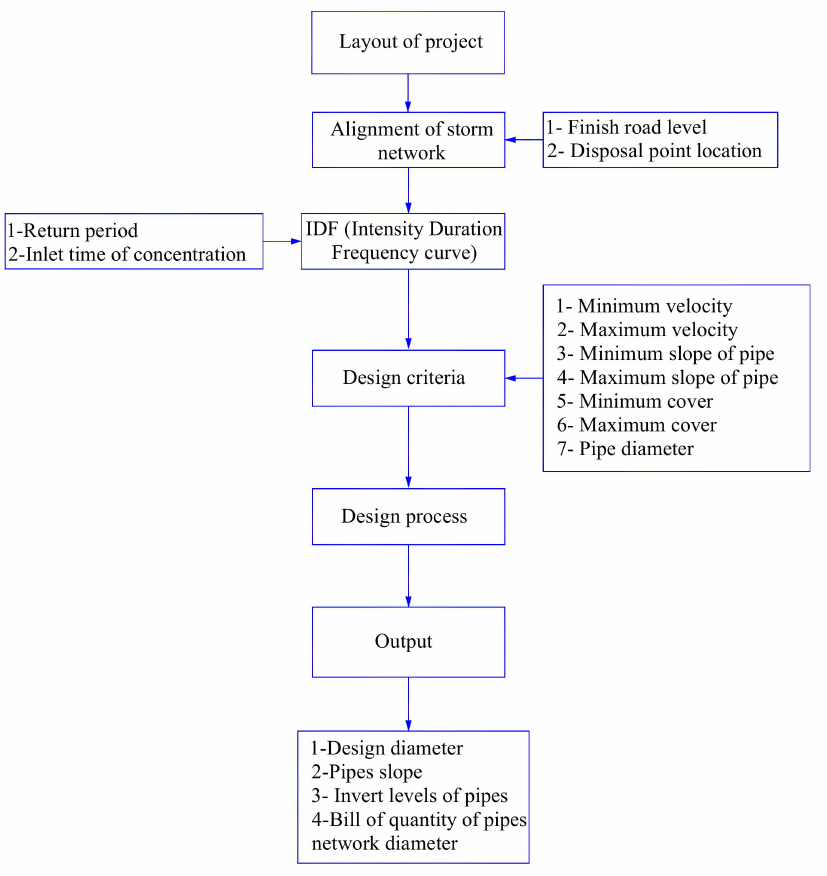
Figure 5. Flow chart of StormCAD simulation process. Table 1. The calculated values of base case for zones A, C and E.